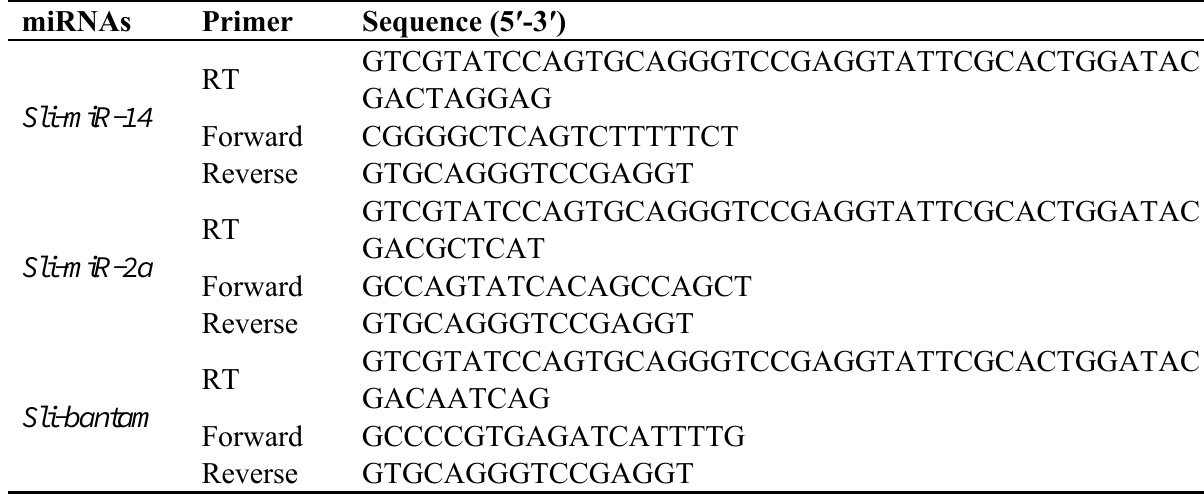
Table 2. Sequences of stem-loop RT primers, forward primers and reverse primers of Group